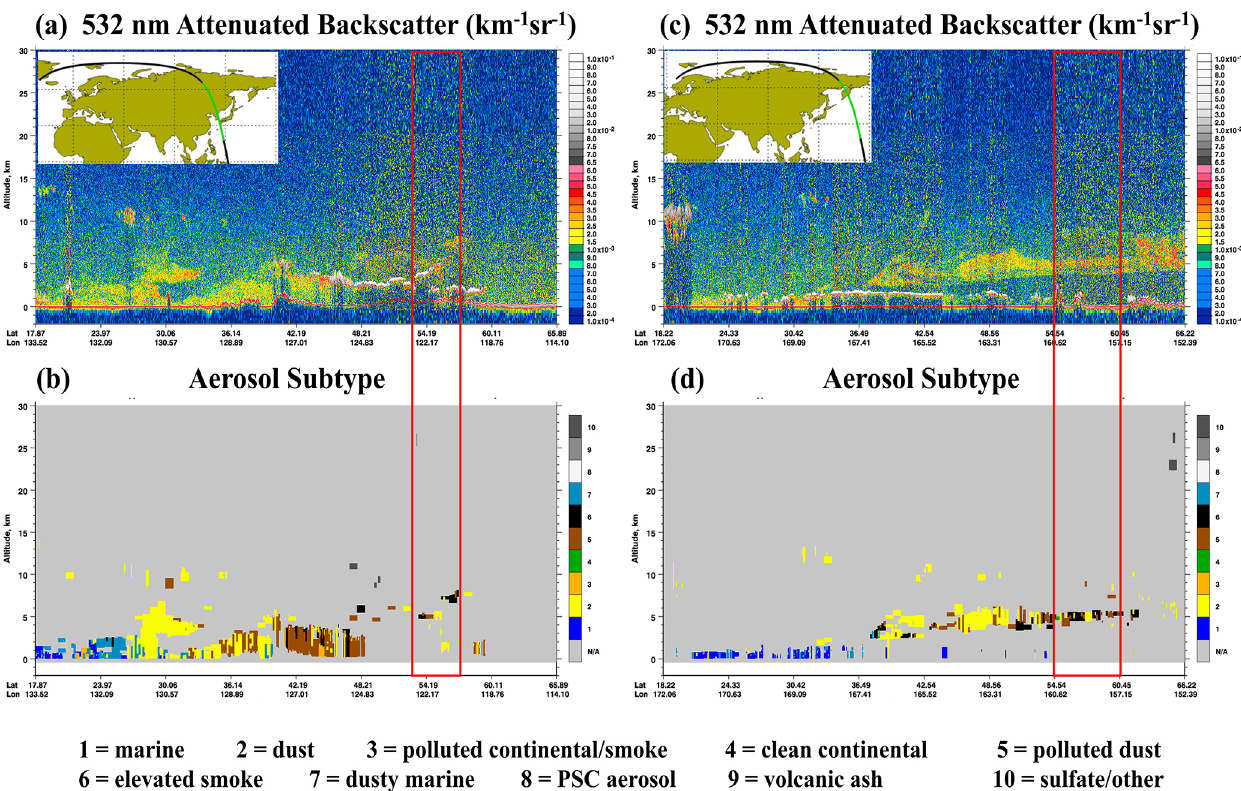
Figure 7. CALIPSO profiles of aerosol backscattering coefficients and identified aerosol types on 17 (a–b) and 18 April 2015 (c–d) . The red rectangles denote the regions as indicated by the CALIPSO tracks in Fig.